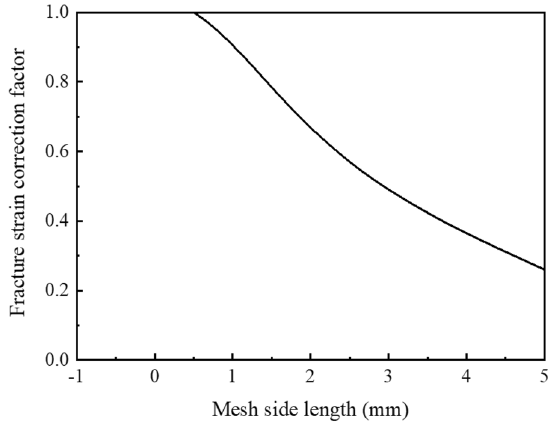
Figure 13 Correction factor curve for mesh